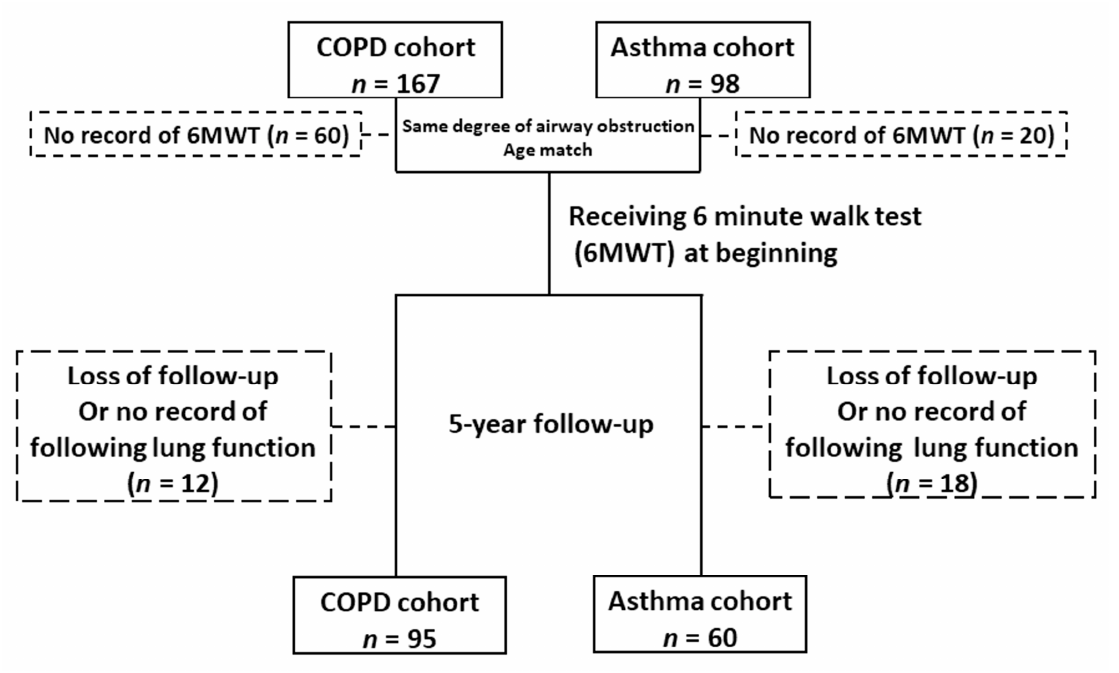
Figure 1. Study flow chart . Abbreviations: COPD, chronic obstructive pulmonary disease.